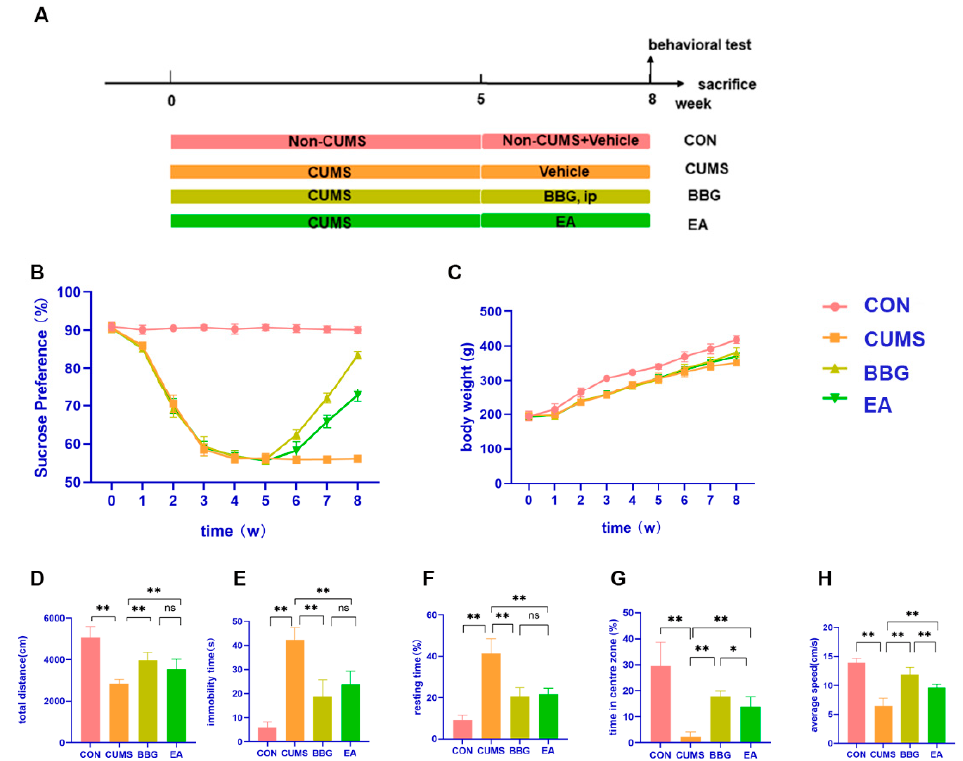
Figure 1. CUMS procedure and effect of EA on body weight gain reduction and depressive, anxiety- like behavior in CUMS rats: ( A ) experimental design, ( B ) sucrose preference test (SPT), ( C ) body weight, ( D , E ) forced swimming test (FST), ( F – H ) open field test (OFT). * p < 0.05, ** p < 0.01.